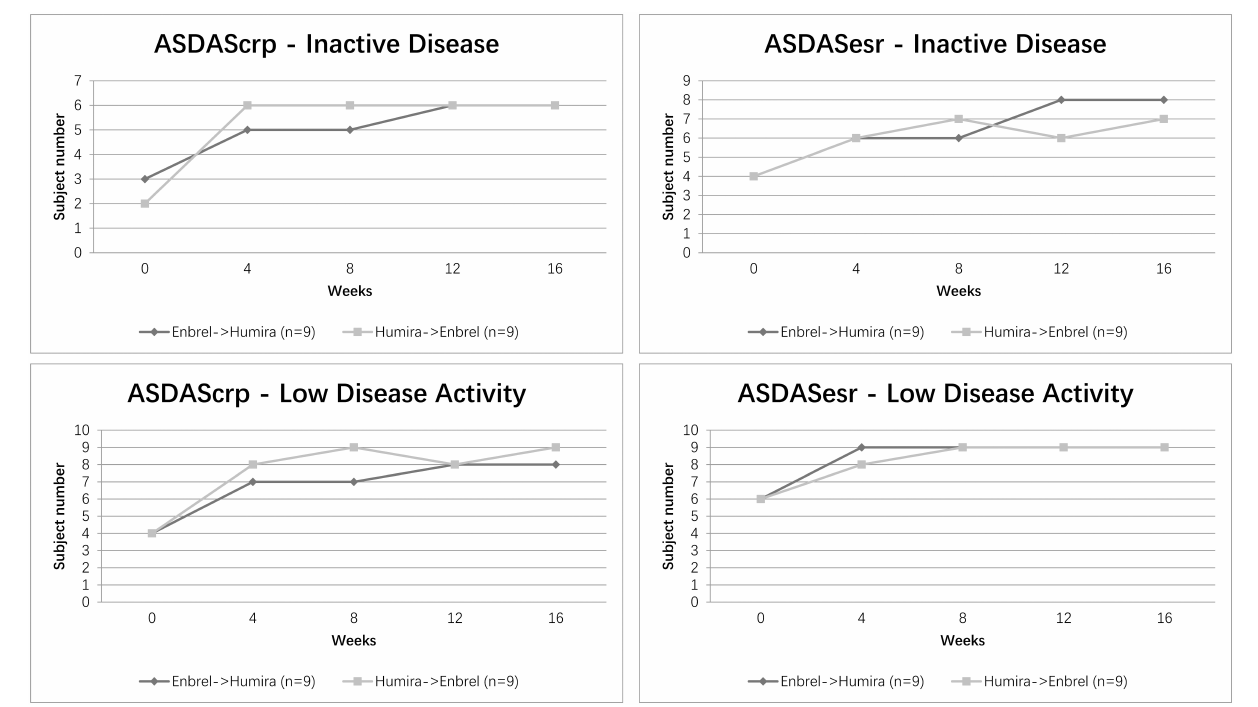
FIGURE 4 | Clinical efficacy assessed by ASDAS ID/LDA status for the two arms. Percentage of patients achieving ASDAScrp and ASDASesr defined ID/LDA at five-time visits from baseline to week 16 was shown.